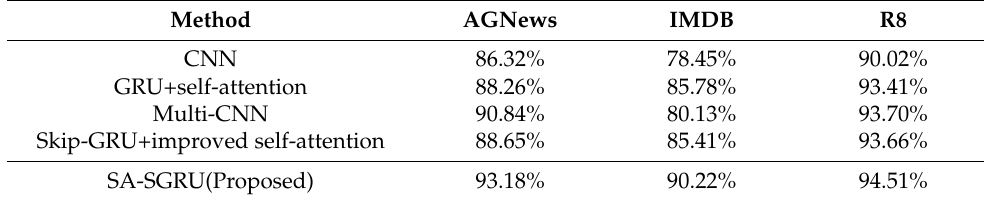
Table 4. Effects of each part of SA-SGRU on classification